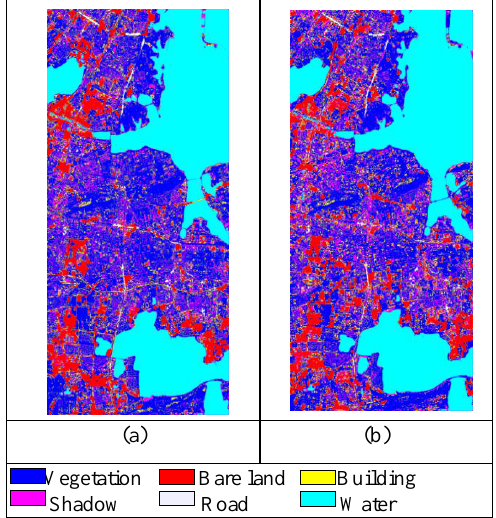
Figure 15. An example of changed area (a) (b) original image; (c) (d) extraction results in changed area